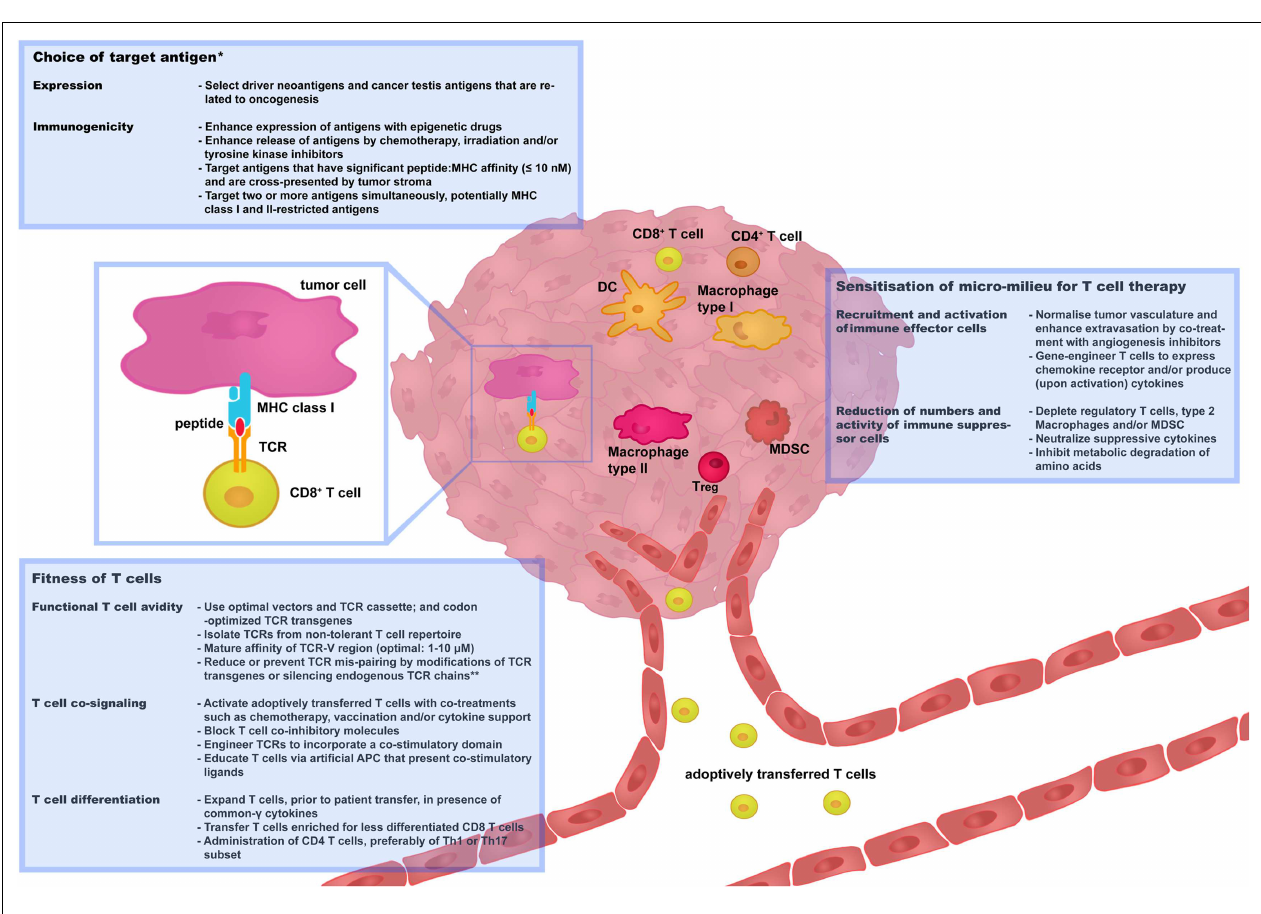
FIGURE 2 |Three challenges that determine the success rate ofTCR gene therapy . In this figure, recent and successful strategies to improve TCR gene therapy have been categorized along three renewed challenges: “choice of target antigen”; “fitness ofT cells”; and “sensitization of micro-milieu forT cell therapy.” Boxes provide selected strategies that are discussed in more detail in Sections “Choice ofTarget Antigen,” “Fitness of T cells,” and “Sensitization of Micro-Milieu forT CellTherapy.”We propose that advancement of clinicalTCR gene therapy is guided by the principles of